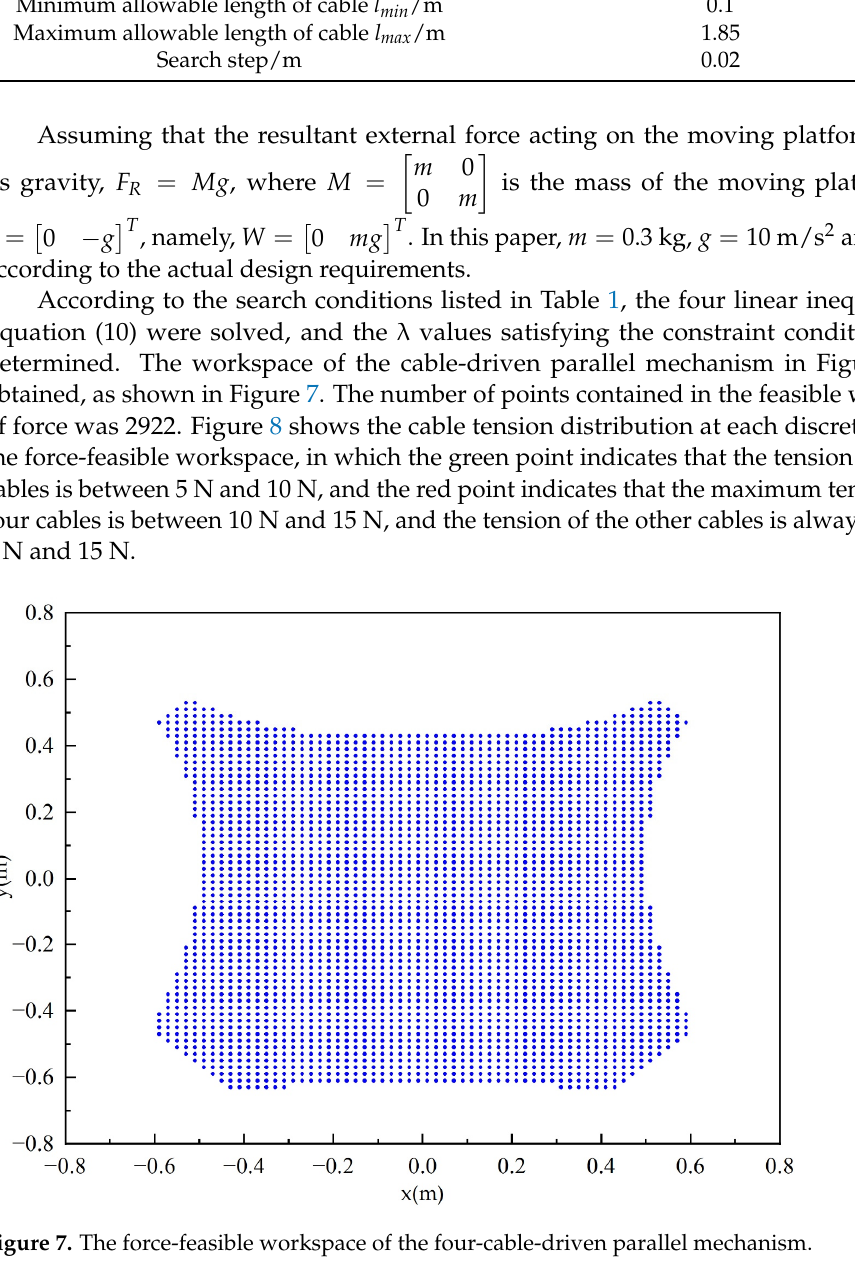
Figure 8. Tension distribution in force-feasible workspace. 3.2. Solution Result of Cable Tension under Typical Trajectory in Workspace The moving platform moves according to the track and planned acceleration shown in Figures 4–6. Equation (13) is used to calculate the cable tension of the three motion tracks, and the tension curve of the four cables as it changes with time is obtained, as shown in Figure 9.